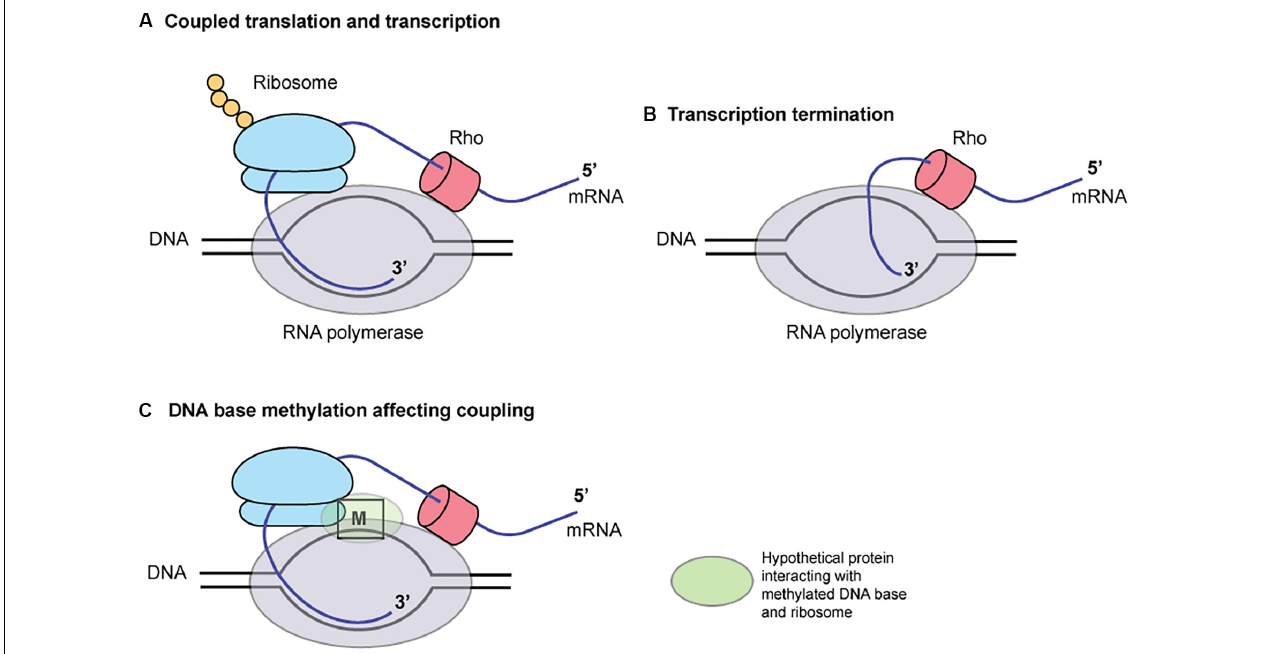
FIGURE 6 | A hypothesis for the role of DNA base methylation in transcription-translation coupling. Translation by ribosome (A) prevents mRNA release by Rho (B) . A hypothetical protein binding the methylated base, (C) RNA polymerase and ribosome affects the coupling. M, a methylated base in DNA.